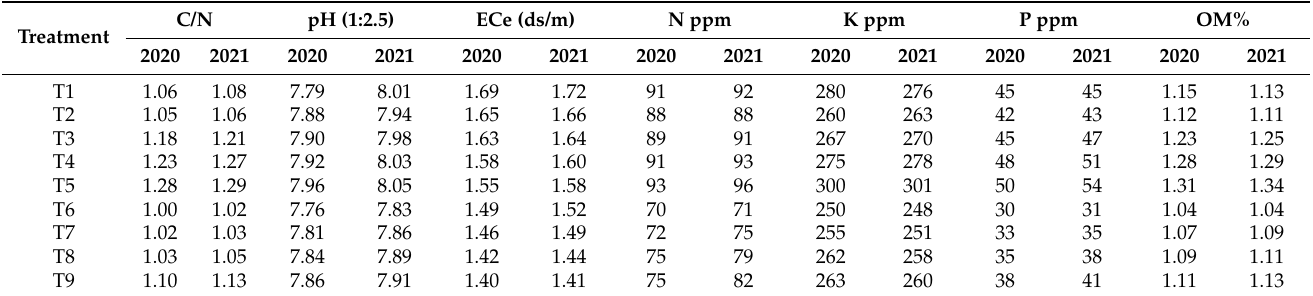
Table 9. Effect of mineral fertilizer alone or combined with superabsorbent polymers (SAP s ) on some chemical properties of the experimental soil in 2020 and 2021